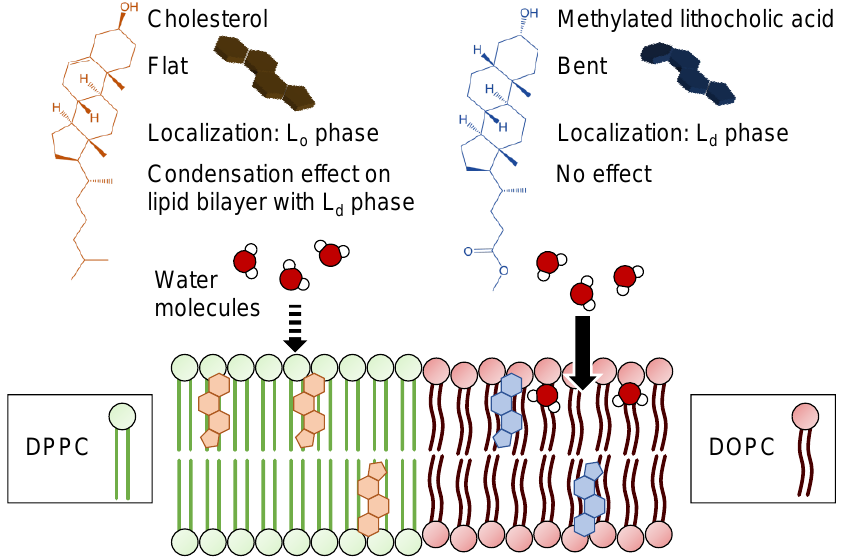
Figure 8. A schematic image of differences in localization and an effect on membrane property between Chol and Me-LCA.